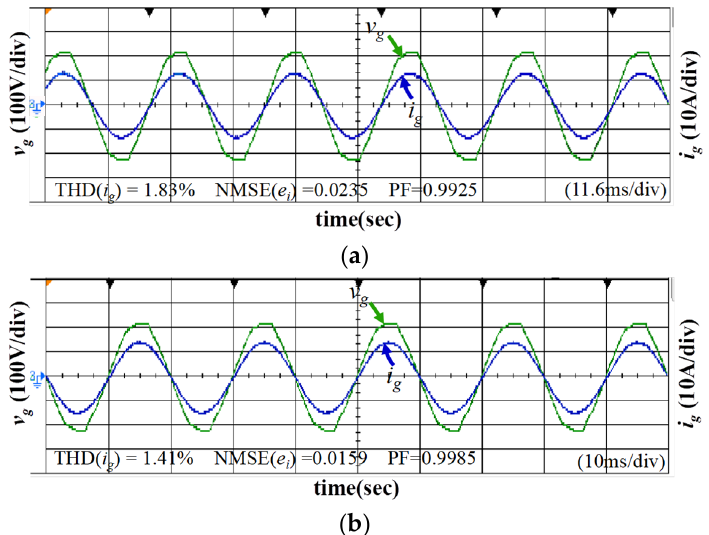
Figure 6. Experimental results of the grid-connected inverter in steady-state: ( a ) GISMC; ( b ) DRFNNISMC.